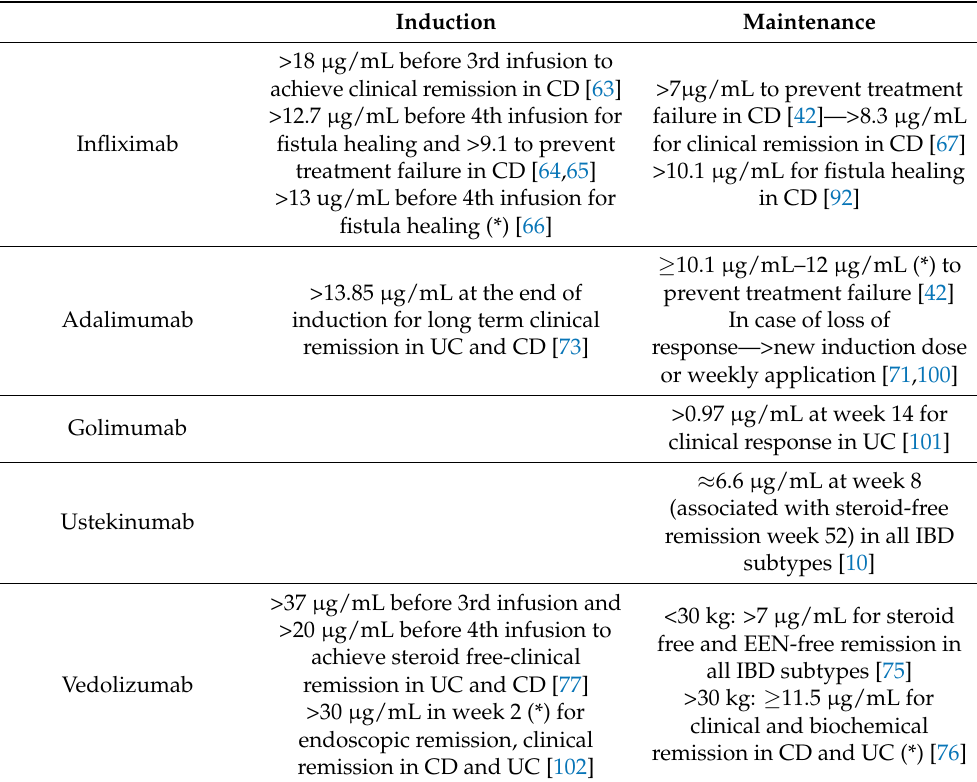
Table 2. Target trough levels during induction and maintenance as reported from recent